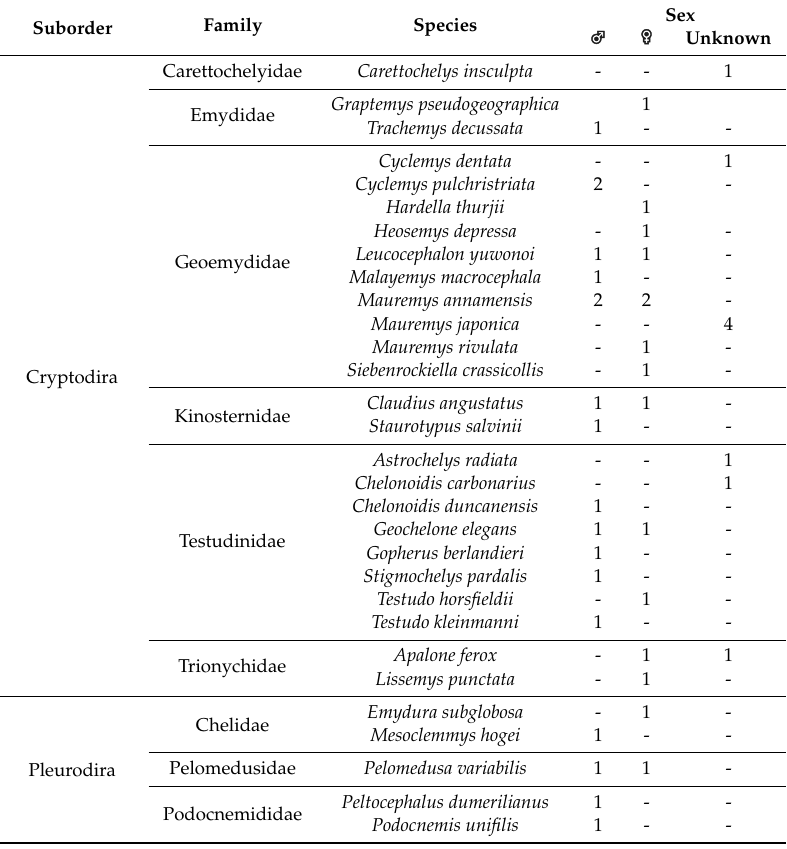
Table 1. Summary of species analyzed in this study.